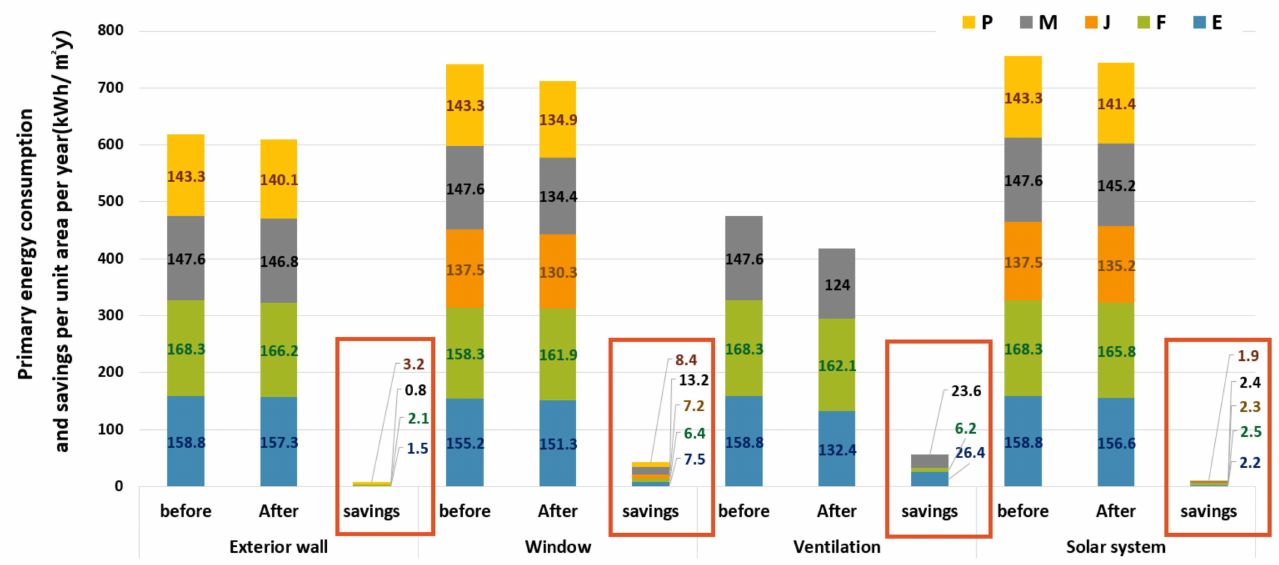
Figure 11. Reduction in primary energy consumption per unit area per year by four improvement factors (kWh/m 2